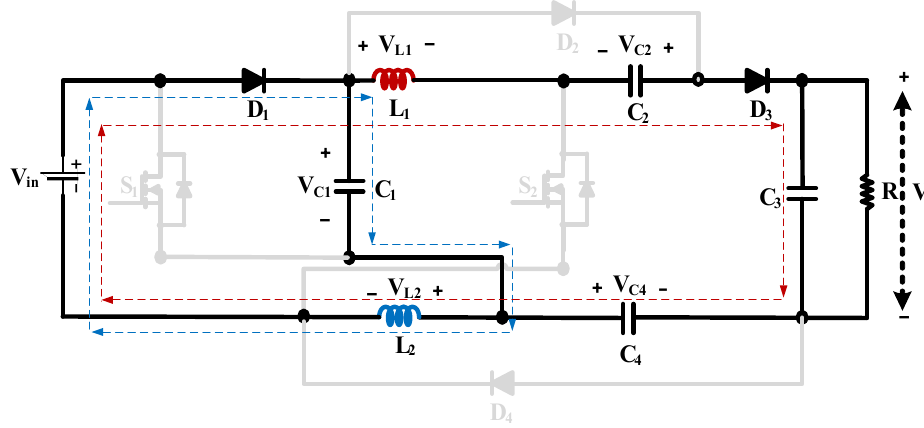
Figure 4. The second mode of operation.